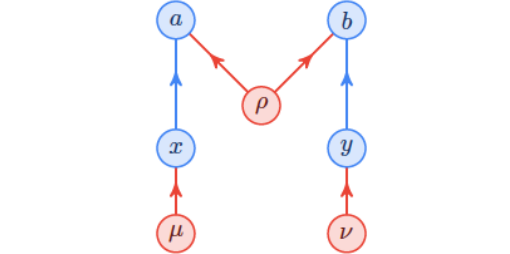
Figure 9: The Bell causal structure has variables a , b ‘measuring’ hidden variable ρ with ‘measurement settings’ x , y deter- mined independently of ρ